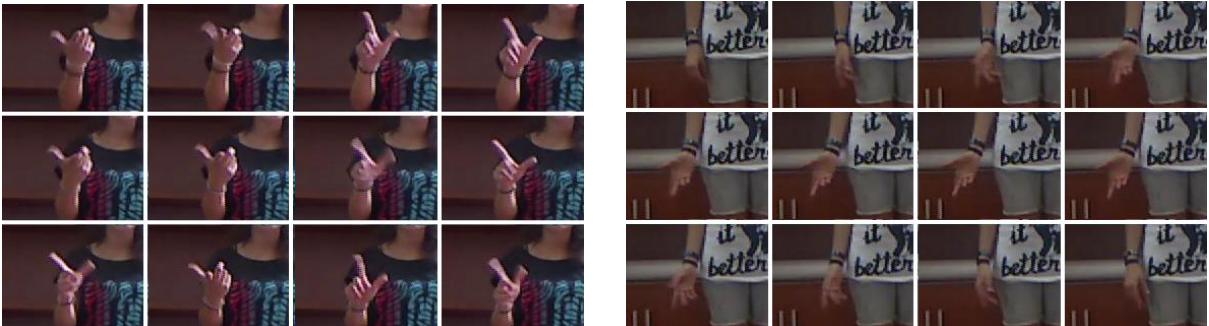
Figure 9. Sample00803, frames